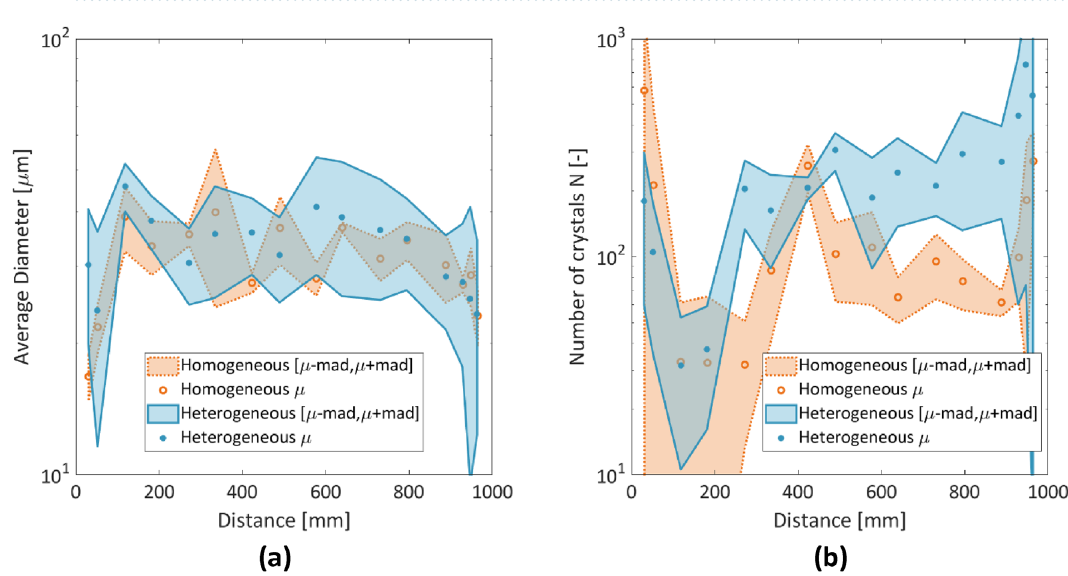
Figure 11. ( a ) Average diameter of crystals. ( b ) Final number of crystals at t = 12 h. Dots represent the averages of the triplicates; shaded areas represent the mean absolute deviation of the